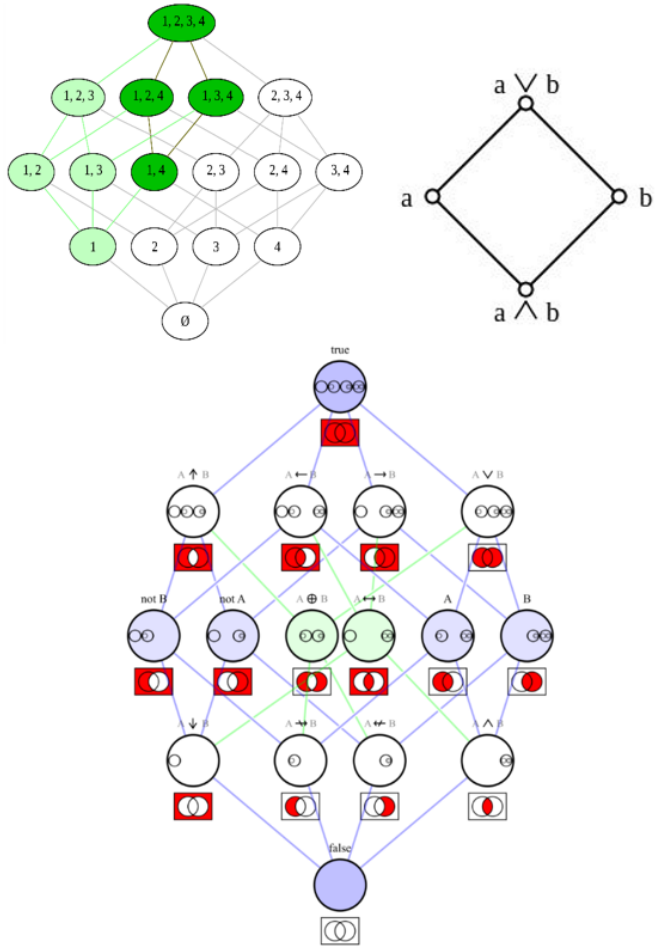
Figure 9. ( Top-left ): Representation of a principal ultrafilter (all the subsets colored in green), that is, the maximal proper filter of the power-set of the 4-element set S { 1,2,3,4 } ordered by inclusion in a Hasse diagram. It has as the principal element or upper set ( ↑ ) the singleton or 1-element set ( ↑ { 1 } ) . The subsets colored in dark green also constitute a proper filter, which is also a principal filter, because it has a principal element, i.e., ( ↑ { 1,4 } ) . However, it is not an ultrafilter because only by adding the subsets coloured in light green, can we obtain the maximal proper filter of this power-set with the principal element ( ↑ { 1 } ) . ( Top-right ): Schematic representation of the meet ( last lower bound ) ( a ∧ b ) and the join ( least upper bound ) ( a ∨ b ) of a Boolean logical lattice, where a and b are two propositional constants. ( Bottom ): Complete Hasse and Venn diagrams of all the propositional connectives representable on a Boolean logical lattice, having as meet (bottom-element ⊥ ) the